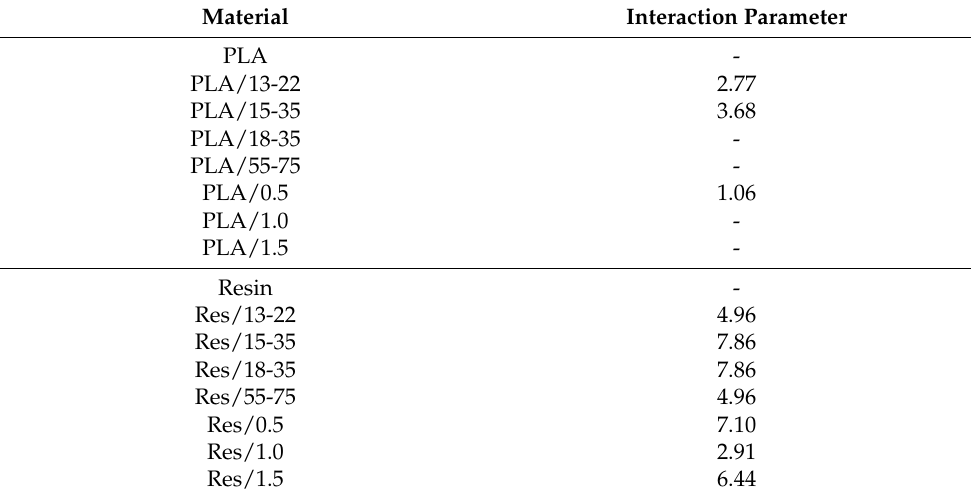
Table 3. Interaction parameter B